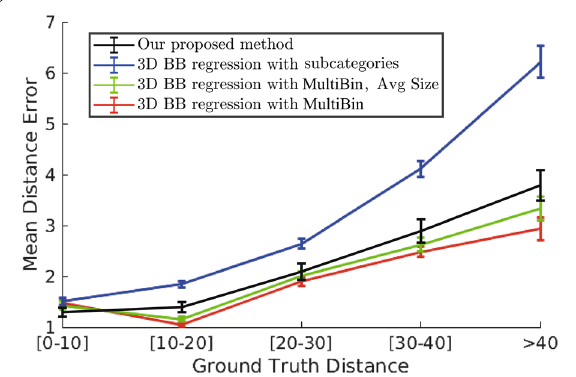
Fig. 13 Mean distance error of the 3D localization in KITTI car dataset. The performance of our method with the standard deviation divided by 10 is superimposed over the result on the paper [5]